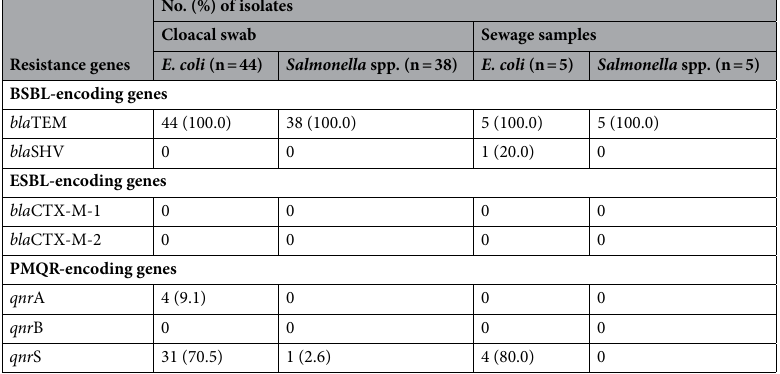
Table 2. Prevalence of β-lactamase-, and PMQR-encoding genes in E. coli and Salmonella spp. isolated from cloacal swab and sewage samples. n No. of isolates, BSBL broad-spectrum β-lactamase, ESBL extended- spectrum β-lactamase, PMQR plasmid-mediated quinolone resistance.